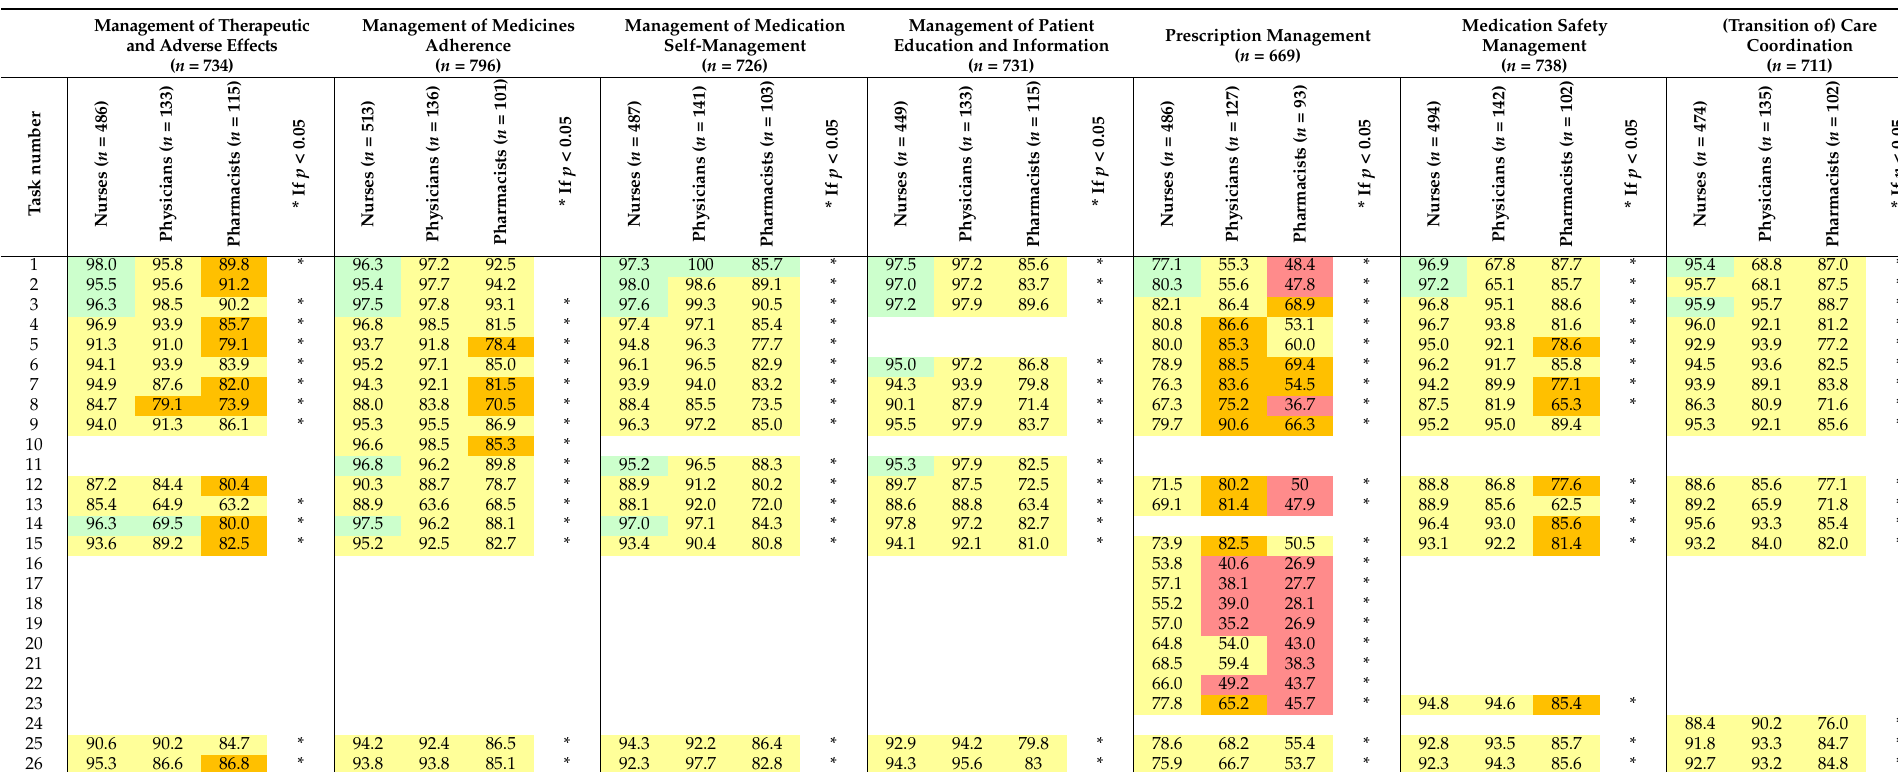
Table A1. Percentages of physicians, pharmacists and nurses considering 26 tasks in seven pharmaceutical care domains as nurses’ tasks in order to obtain best quality of care and patient